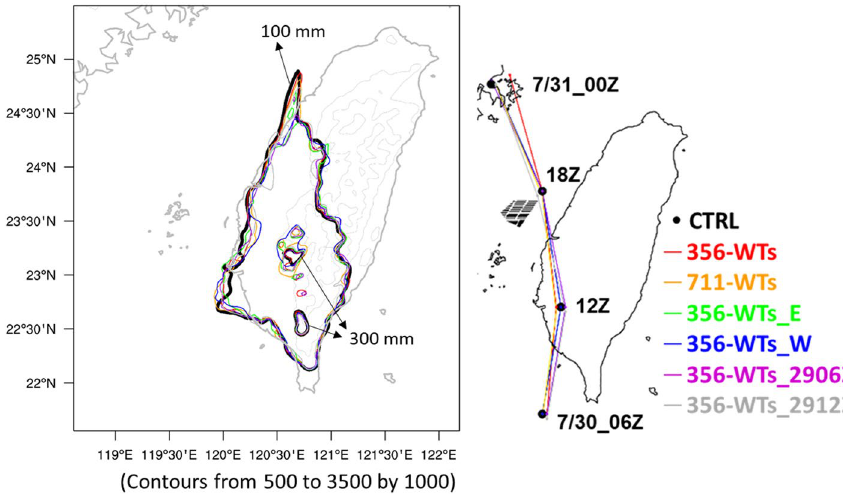
Figure 8. 12-h accumulated precipitation over Taiwan during 12:00–23:00 UTC on July 30, 2017 and the track of Tropical Storm Haitang for all experiments. The outter and the inner contour lines indicate the precipitation of 100 mm and 300 mm, respectively. The grey contours indicate the terrain height (m). Maps and plots were produced using NCAR Command Language (NCL) version 6.6.2 37 .